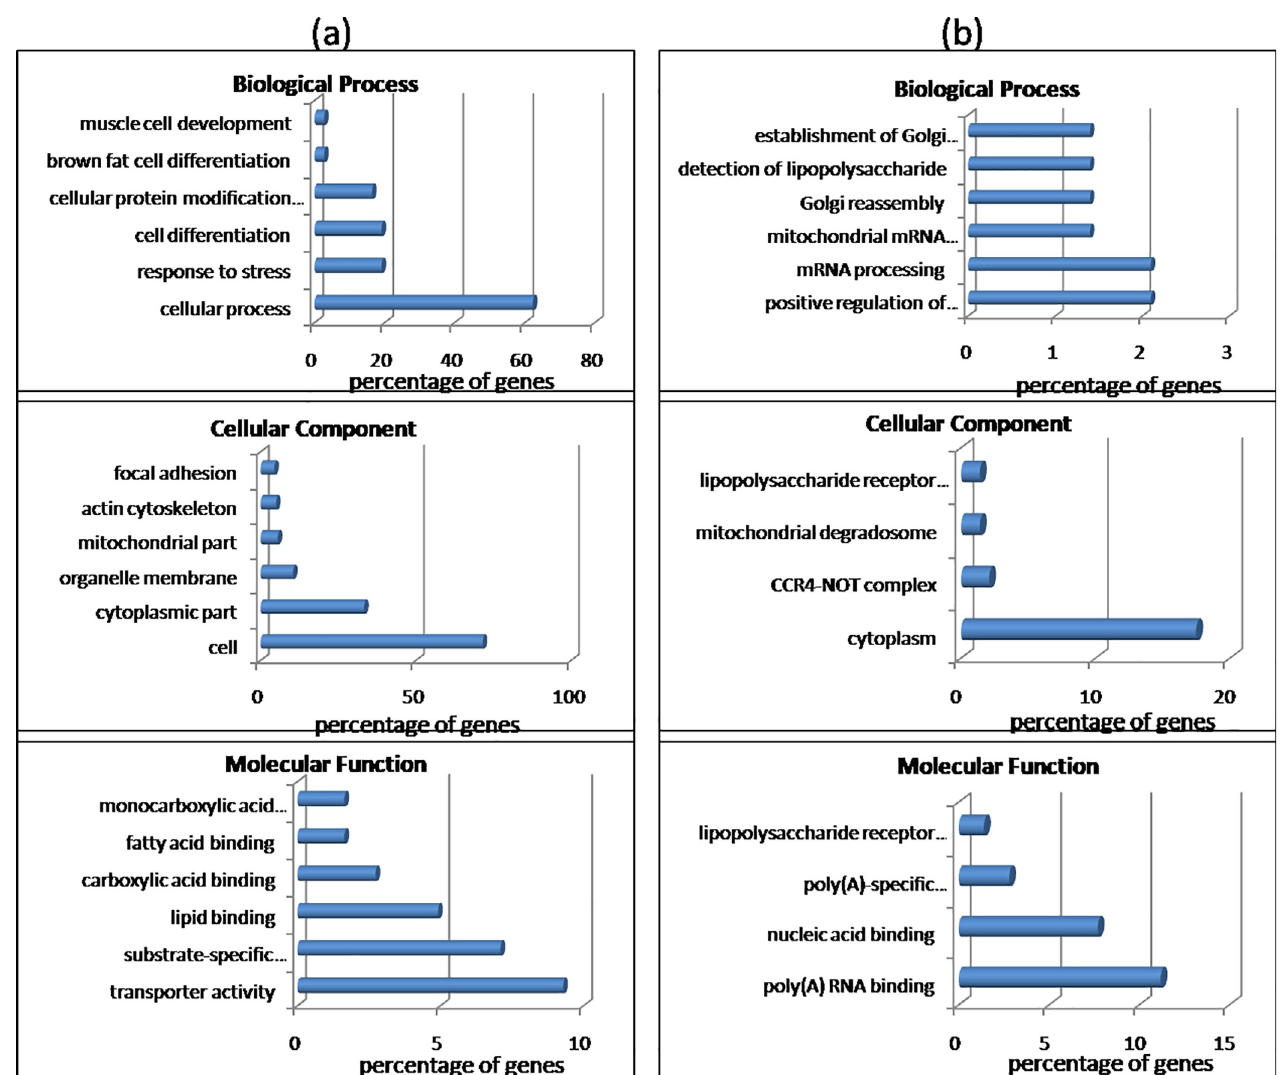
Fig 2. Gene Ontology terms for different categories for (a) up-regulated and (b) down-regulated DE genes in Bandur sheep.